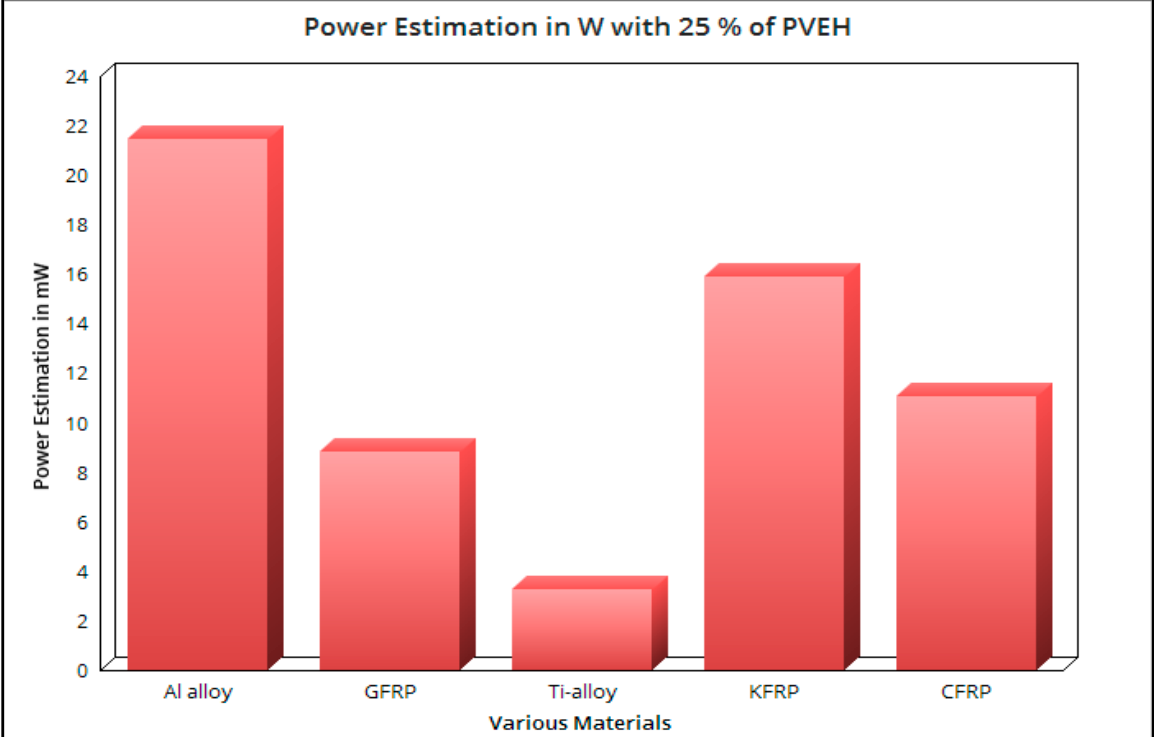
Figure 43. Power (P 0 ) in W with 25% attachment coverage-UAV wing.